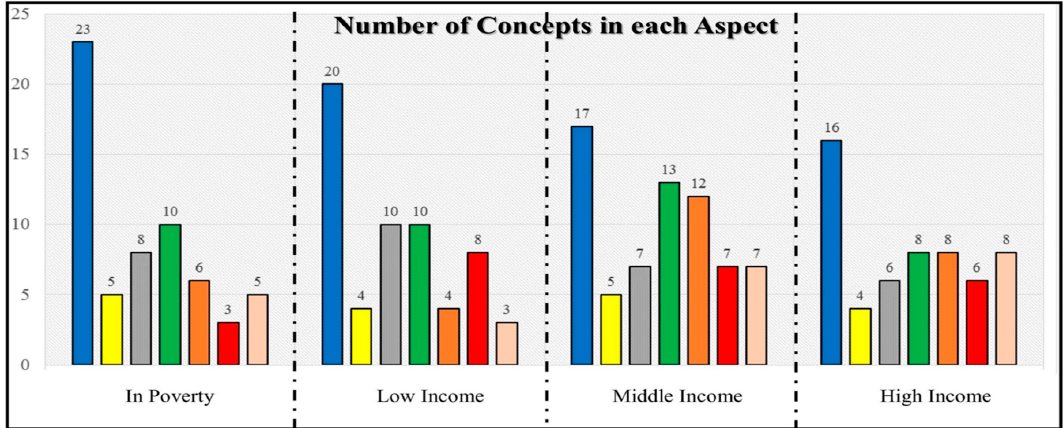
Figure 8. Frequency of concepts per sector in cognitive maps per income group. The colors refer to sectors as follows health, economic aspects, social aspects, energy and natural resources, infrastructure, hazard and damages, life style.